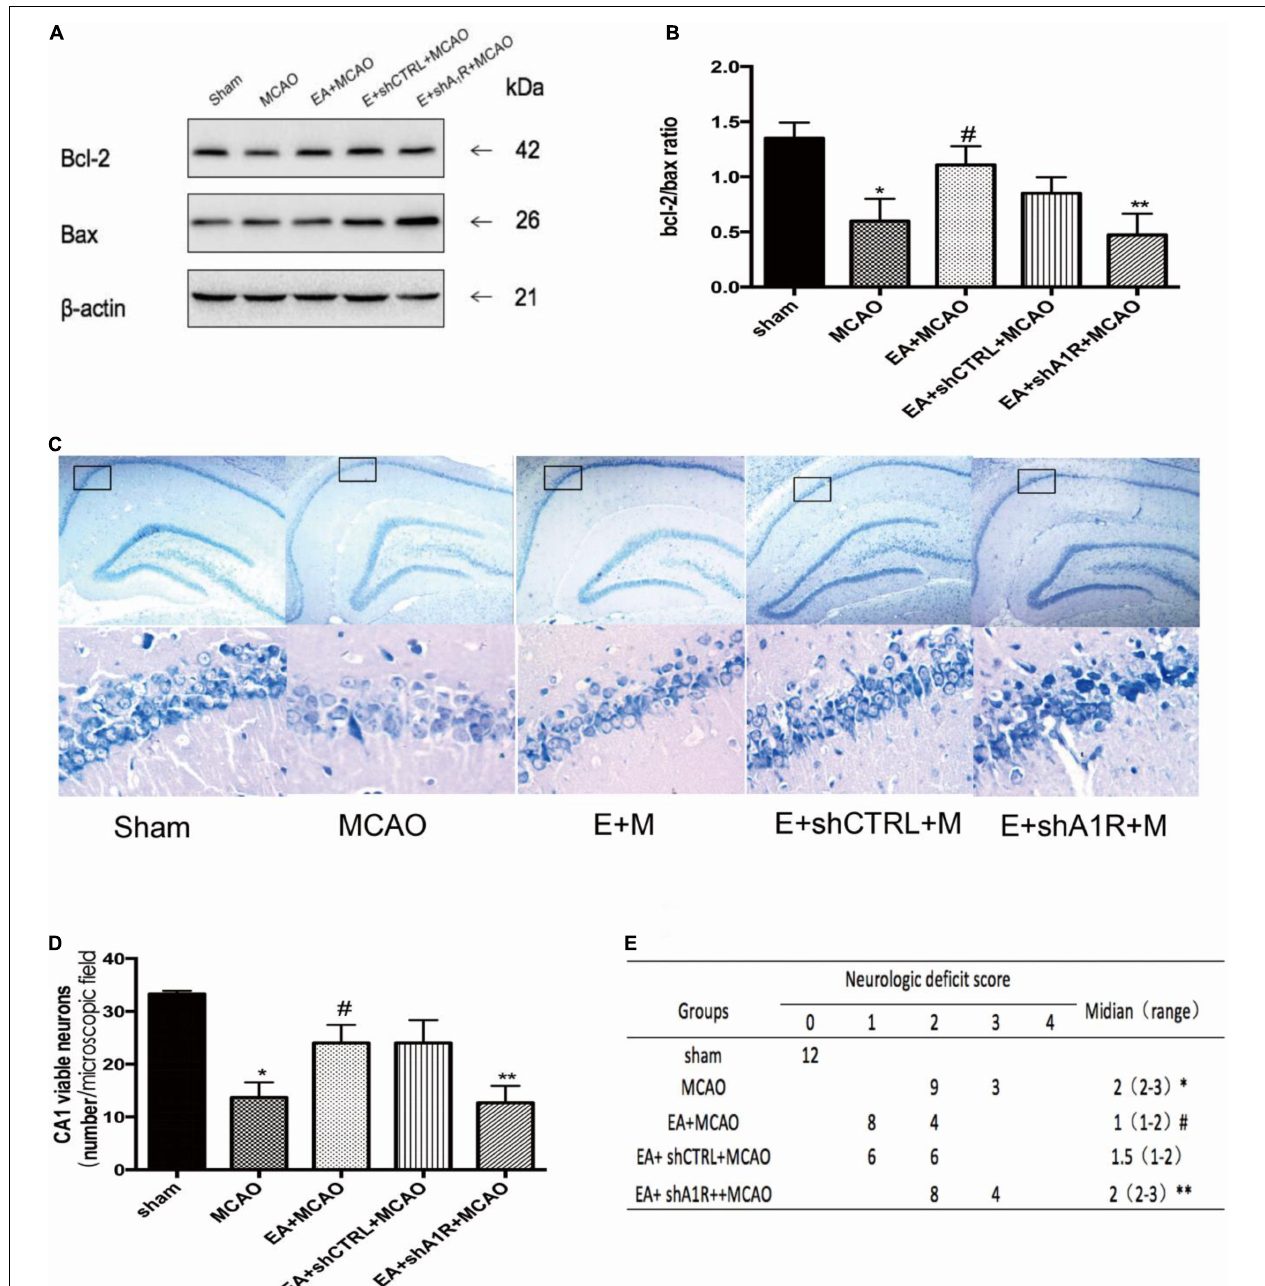
FIGURE 9 | Effect of AV-shA1R on neuroprotection. (A,B) Western blot analysis for Bcl-2 and Bax protein expression in the hippocampal CA1 region ( n = 3). (C,D) EA pretreatment significantly increased the number of viable pyramidal neurons in the hippocampal CA1 region ( n = 3),whereas AV-shA1R attenuated these beneficial effects. (E) Neurologic behavior scores were determined 24 h after reperfusion. * P < 0.01 vs. the sham group, # P < 0.05 vs. the MCAO group, ** P < 0.05 vs. the EA + MCAO